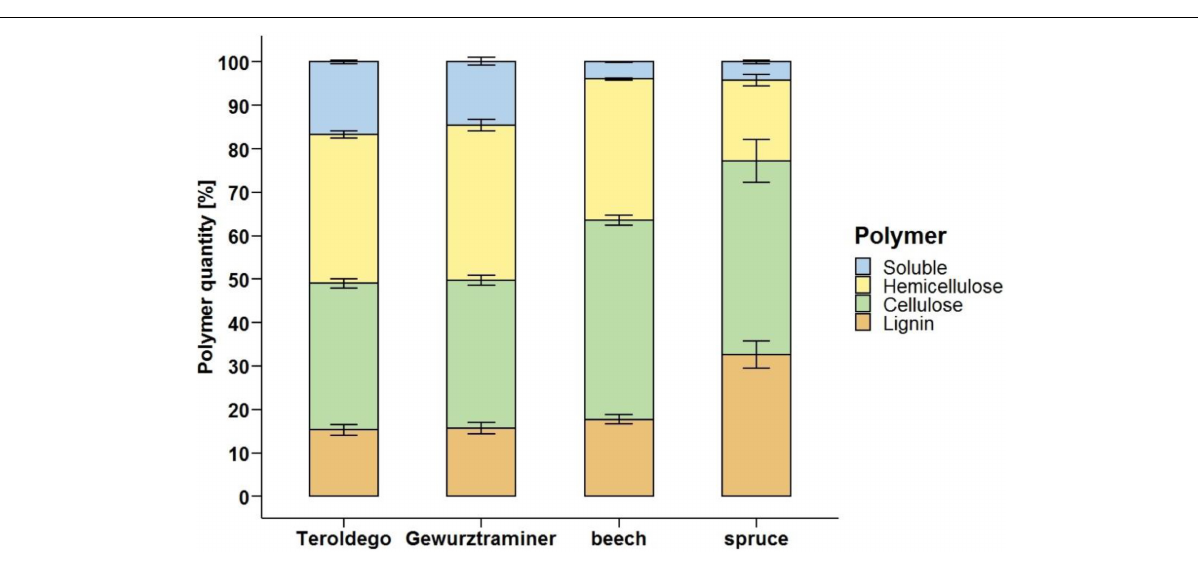
FIGURE 6 | Grapevine (cv. Teroldego and cv. Gewurztraminer), beech, and spruce undegraded wood composition. Comparison of grapevine wood polymer composition to soft- (spruce) and hardwood (beech) profiles. Polymer content measures were performed on non-inoculated sound wood